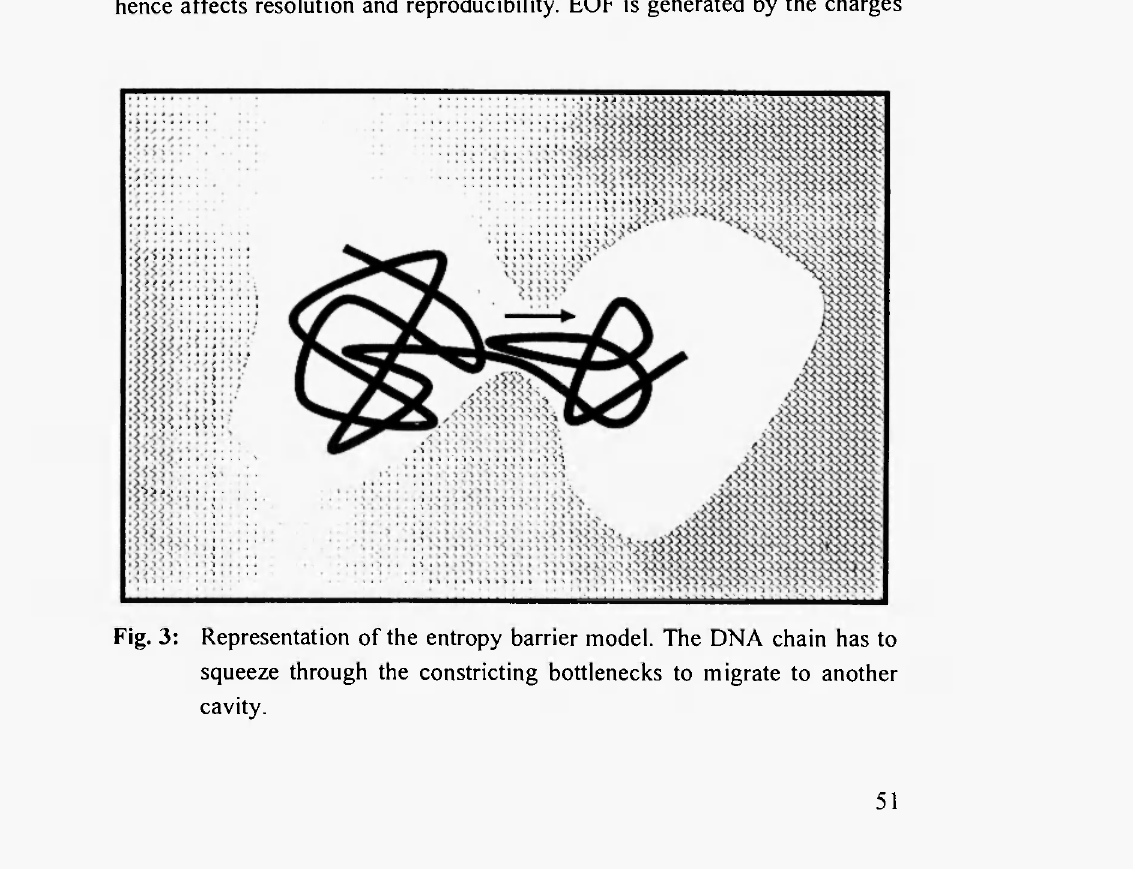
Fig. 3: Representation of the entropy barrier model. The DNA chain has to squeeze through the constricting bottlenecks to migrate to another